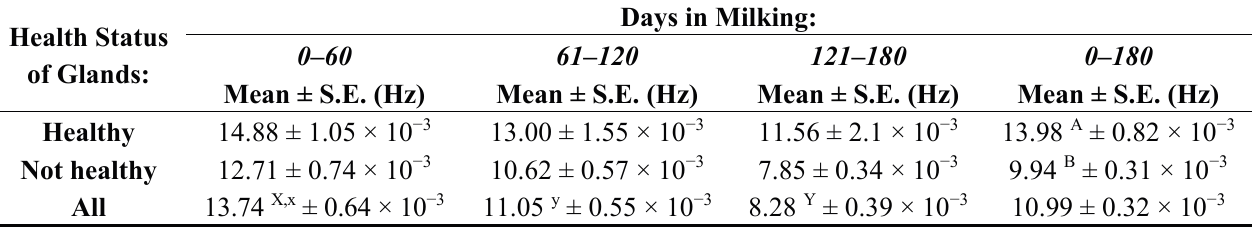
Table 6. Overall means and standard errors of the frequency of peak FFT_P 1 , according to health status and lactation stages.